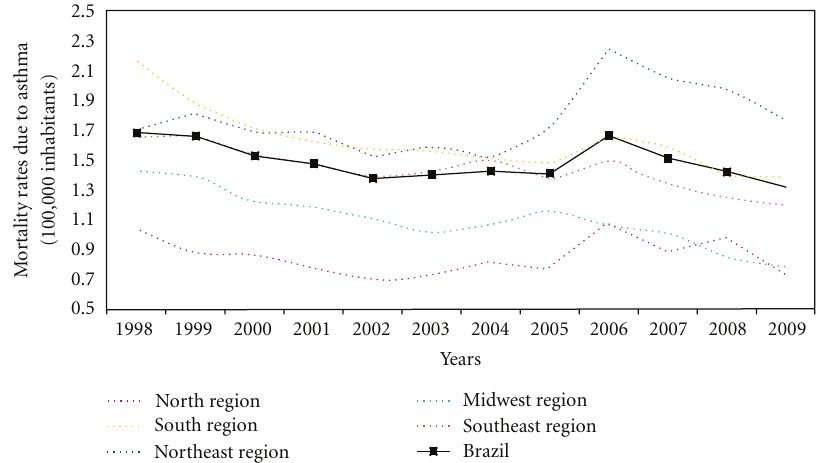
Figure 1: Asthma mortality rates due to asthma, per 100,000 inhabitants, in Brazil and in its regions in the period between 1998 and 2009. Table 1: Mortality rates due to asthma per 100,000 inhabitants in Brazil and in its regions in the period between 1998 and 2009. Locality